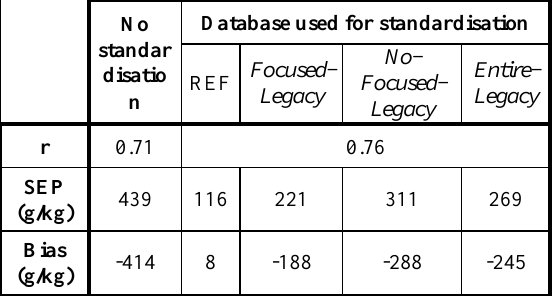
Table 2: Performance of prediction